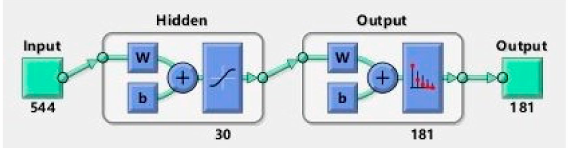
Figure 10. Structure of BP neural